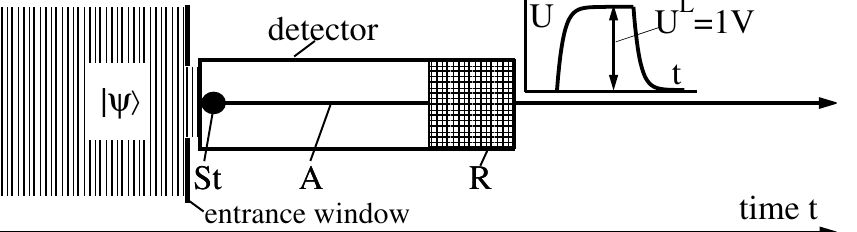
Figure 2. Detection of a particle in a fully operable detector according to the three-phase model (schematic representation of the time dependence, ”St” stays for ”start reaction”, ”A” denotes amplification, and ”R” denotes readout). Detector and discriminator generate a detectable output signal U L if, and only if, the particle has initiated the start